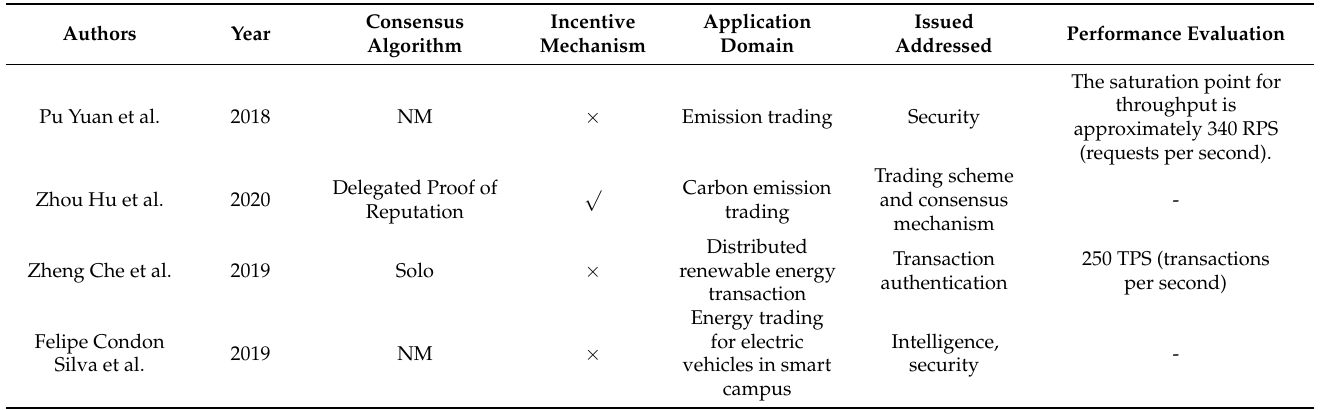
Table 9. Differences between schemes of smart energy (NS: mention but not specify, NM: not